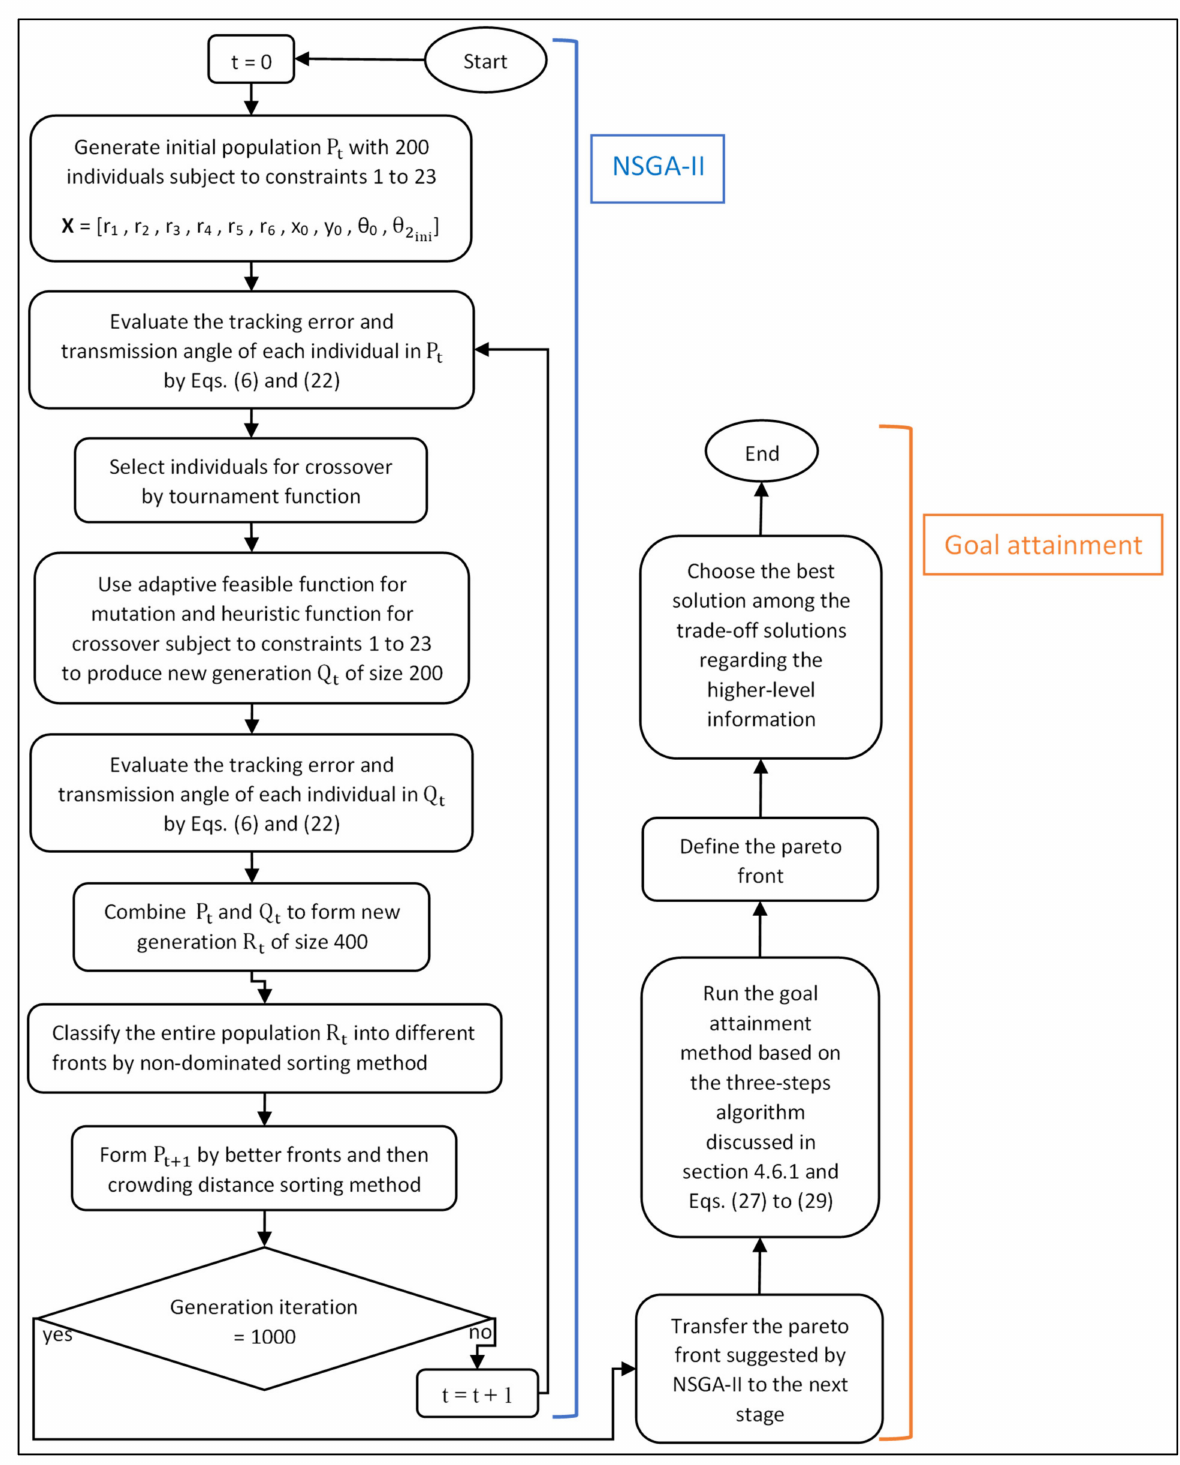
Figure 5. Flowchart of HGA for the four-bar cultivator